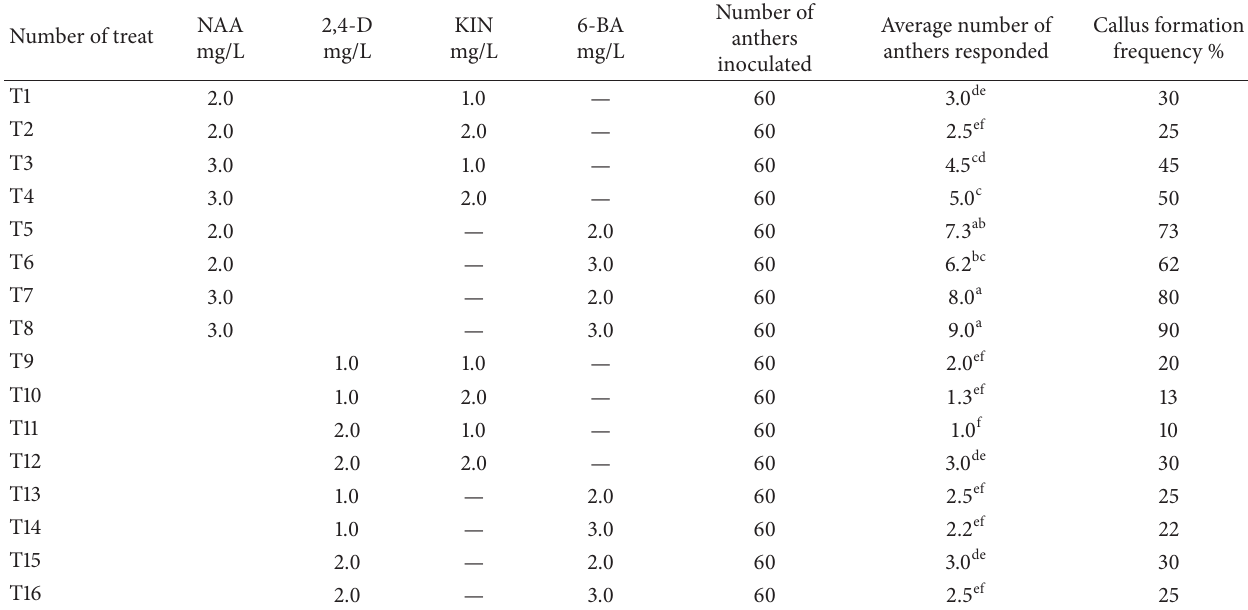
Table 3: Effect of the different types of PGR on callus